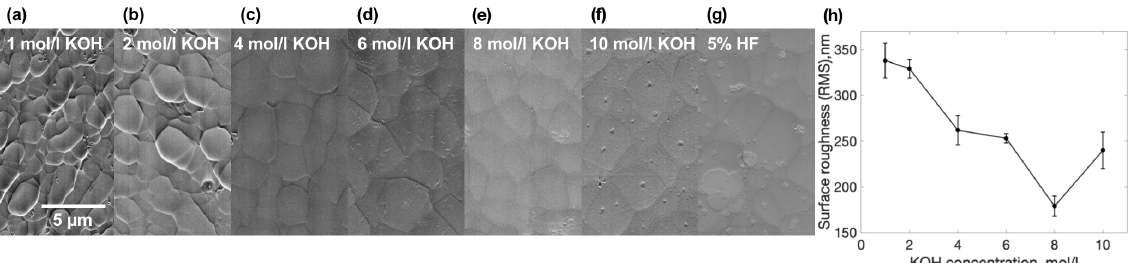
Figure 5. ( a – g ) SEM micrographs of surfaces etched in various concentrations etchants. ( h ) Surface roughness dependency on etchant